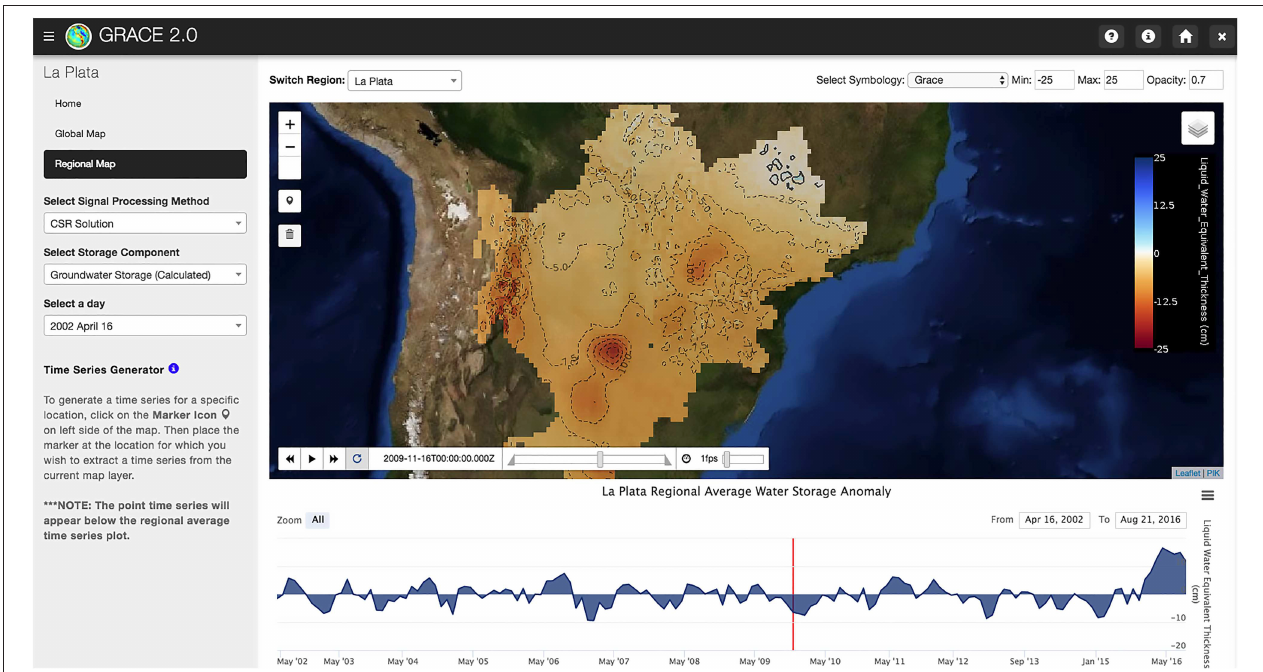
FIGURE 11 | GRACE Tethys app illustrating groundwater storage anomaly for the La Plata Basin in South America.